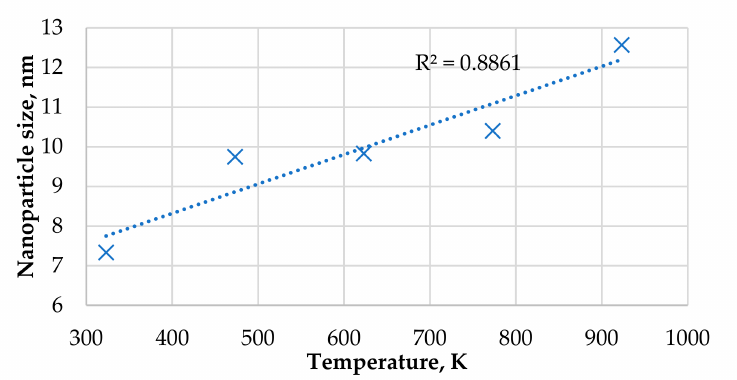
Figure 4. Plot of nano-particle size of phase A (in the horizontal directions) vs. substrate temperature at the relative flux of arriving particles of i = 1 s − 1